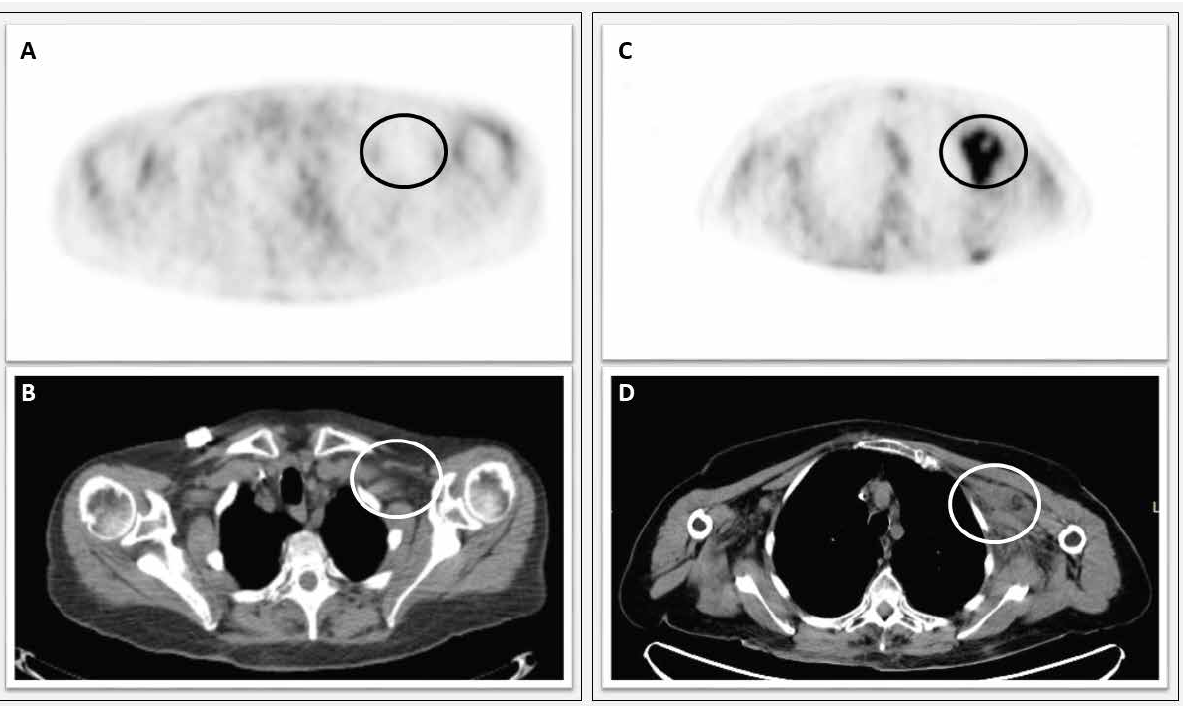
Figure 4: Left side: instrumental follow-up after first-line chemotherapy. A) [18F] FDG-PET performed with co-registered CT did not show marked areas of increased metabolic activity in the left subclavicular site (SUV 1.86) (black circle). B) CT showing in the same site homo- geneous densitometry lymphadenopathy (white circle). Right side: Progression of the disease after second-line chemotherapy. C) [18F] FDG-PET performed with co-registered CT documented an increase in metabolic activity at the left subclavicular site (SUV 4.7) (black circle). D) CT examination documented in the PET collection site the presence of inhomogeneous solid tissue with an intralesional necrotic area (white